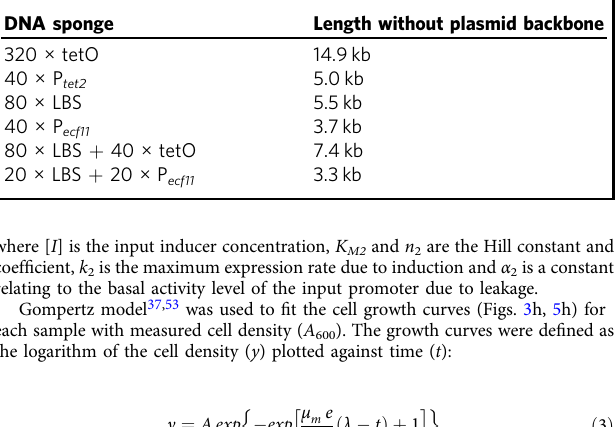
Table 1 DNA sponges selected for plasmid stability